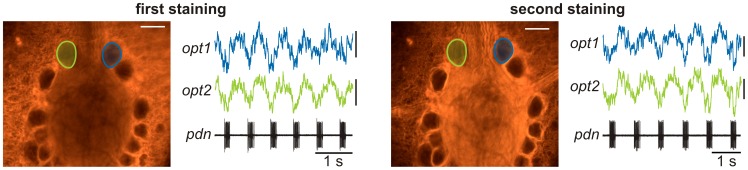
Repetitive staining permits long-term experiments.Photos with regions of interest and simultaneous single-sweep recording of two pyloric neurons, plus pdn. Left: first staining; right: second staining. Recordings were taken roughly 5 hours apart from one another. Staining duration was 1 hour in each case. Scale bars: 100 µm (photo) and 0.1% (optical recordings).